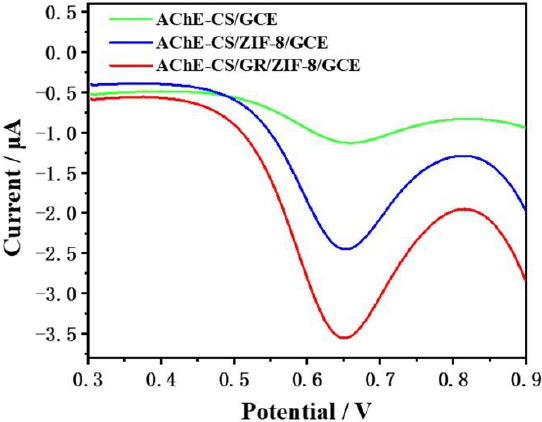
Figure 4. DPV response curves of enzyme electrodes modified with different nanomaterials in 0.1 M PBS buffer solution containing 1 mM ATCl.